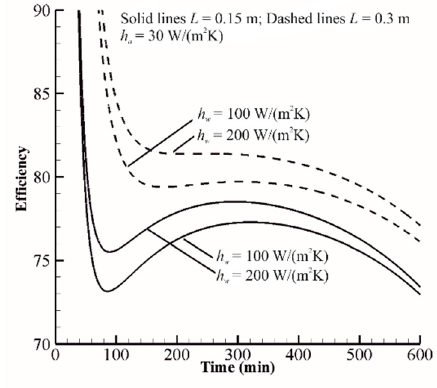
Figure 11. Efficiency versus time.